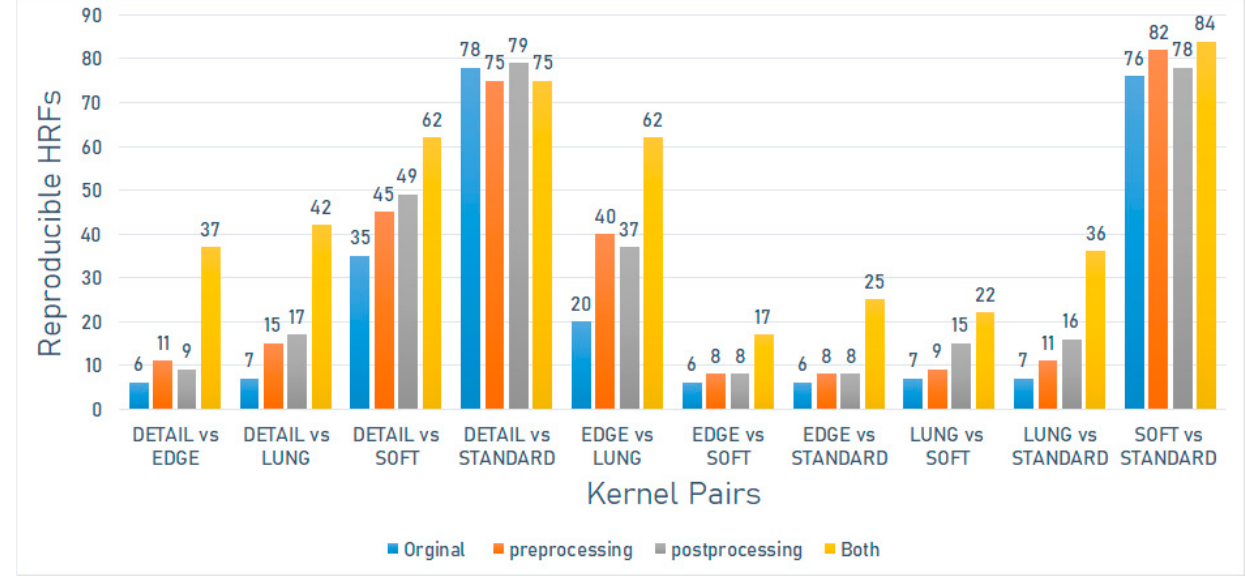
Figure 2. The number of reproducible HRFs across different kernels on the Discovery STE scanner model.